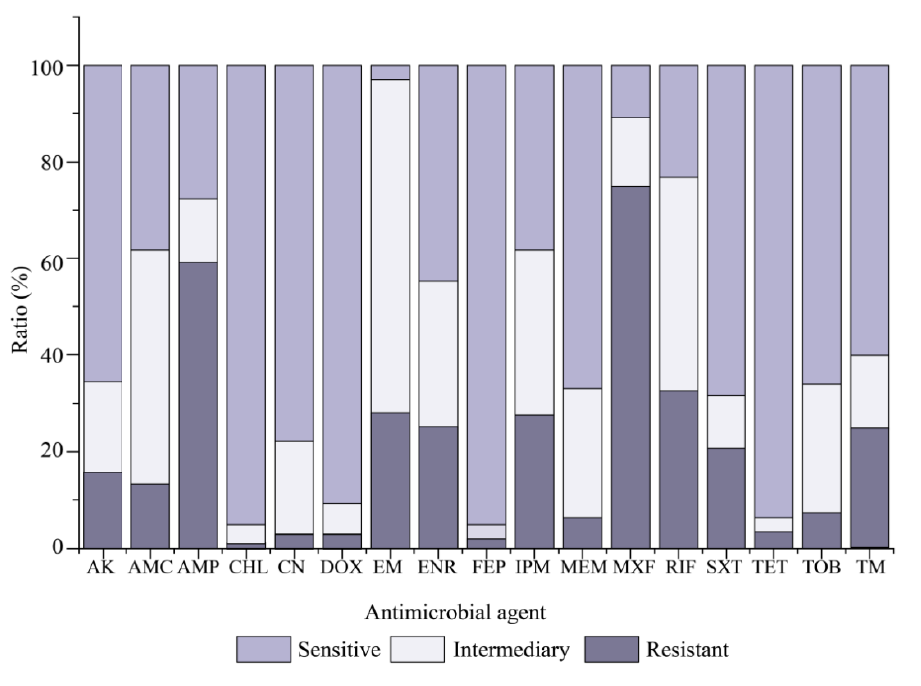
Figure 3. Antimicrobial susceptibility of the 203 V. cholerae isolates to 17 antimicrobial agents evaluated in this study. AK, amikacin; AMC, amoxicillin/novobiocin; AMP, ampicillin; CHL, chloramphenicol; CN, gentamicinm; DOX, doxycycline; EM, erythromycin; ENR, enrofloxacin; FEP, cefepime; IPM, imipenem; MEM, meropenem; MXF, moxifloxacin; RIF, rifampin; SXT, sulfamethoxazole-trimethoprim; TET, tetracycline; TOB, tobramycin; and TM, trimethoprim.